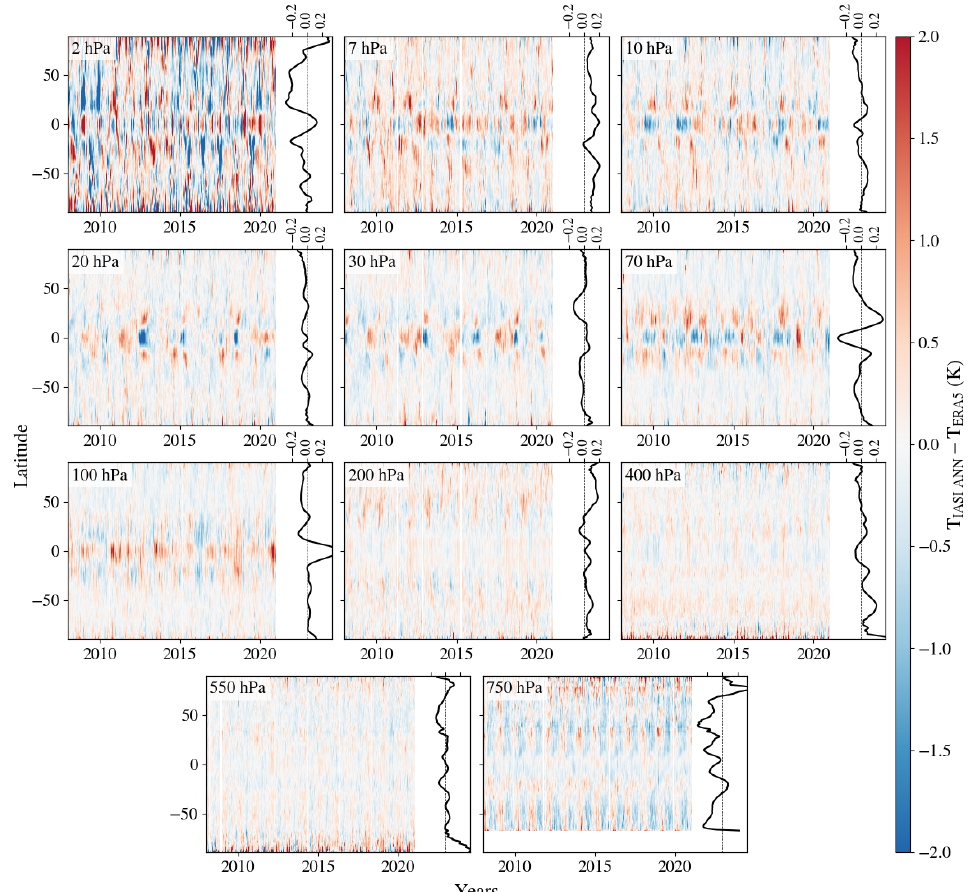
Figure 3. Daily zonal mean differences between IASI and ERA5 zonal mean temperature for the 11 pressure levels of the ANN, with the time-averaged differences on the right of each